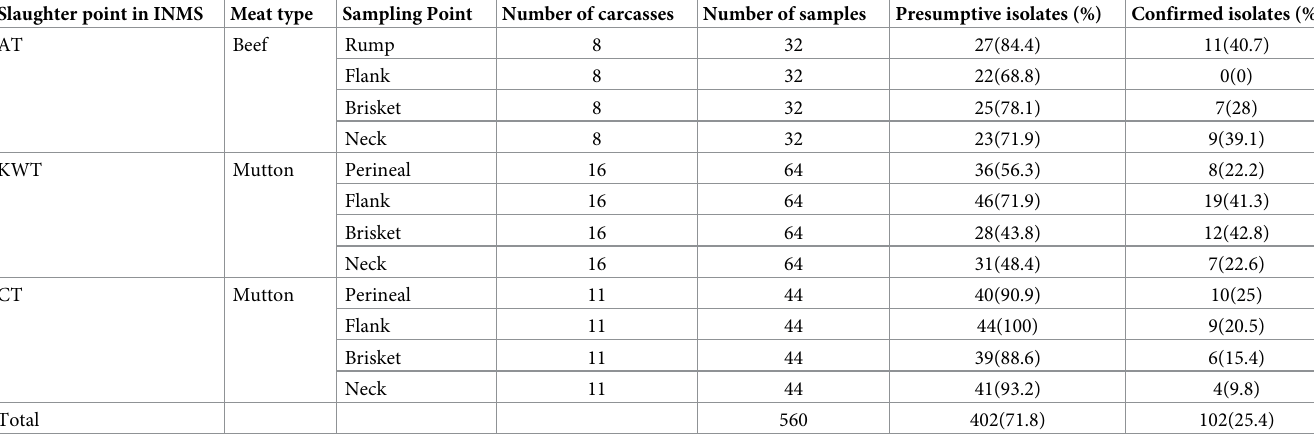
Table 2. Percentage of confirmed isolates from meat slaughter points in Alice (n = 8), King William town (n = 16), and Cala (n = 11). Slaughter point in